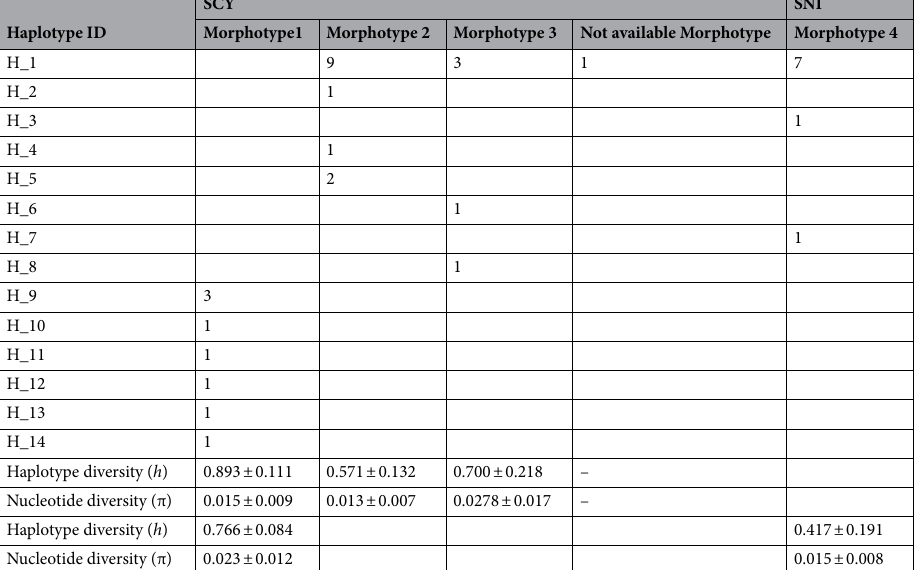
Table 3. Absolute haplotype frequencies and genetic diversity indices (haplotype diversity (h) and nucleotide diversity (π)) with their standard deviation for SCY and SNI and for different morphotypes within SCY using mitochondrial DNA control region (mtDNA-CR) sequence data.